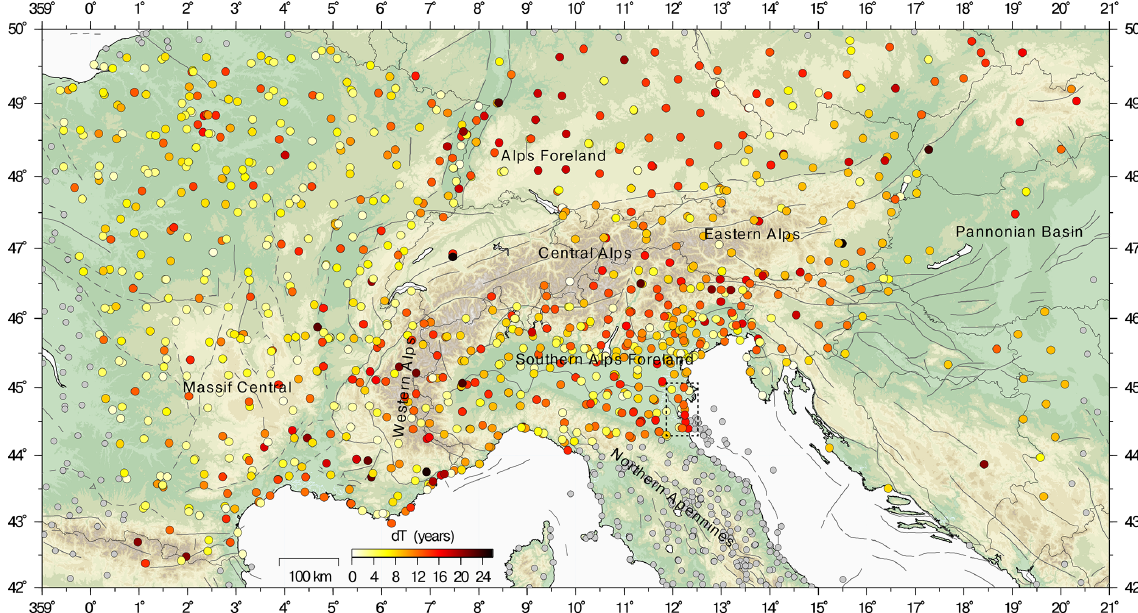
Figure 1. Map of the study area showing the location of GNSS stations. Colored circles show GNSS stations considered in the time series analysis, with colors representing the length of the time interval for which data are available at each station (0–25 years). The grey circles show GNSS stations not included in the time series analysis to reduce contamination of deformation processes not associated with the Alps. Dark grey lines represent mapped faults from the Geodynamic Map of the Mediterranean (Morelli and Barrier, 2004). The dashed box includes GNSS stations affected by anthropogenic deformation signals (Palano et al.,